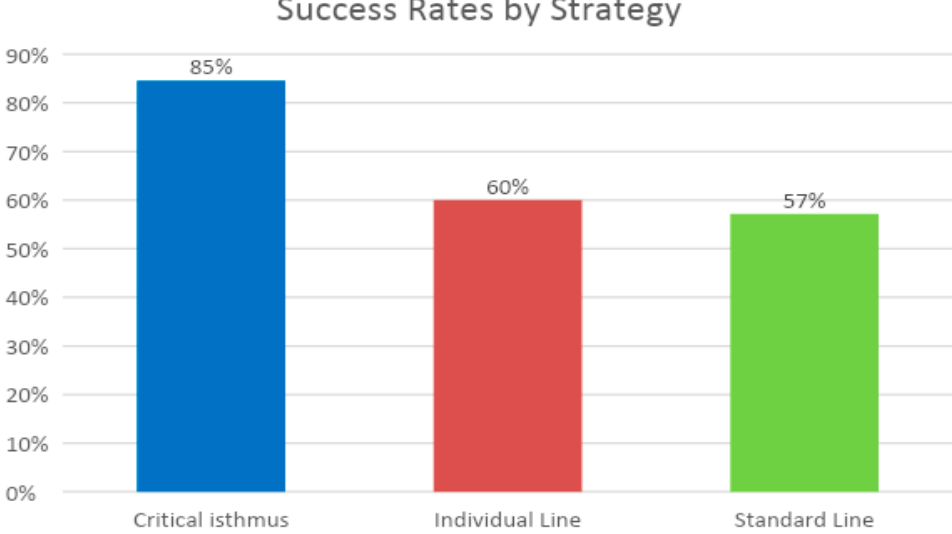
Figure 4. Clinical success dependent on the ablation strategy. Multi-procedure success after a mean follow-up time of 30 months. Differences were not significant. (Pearson Chi Square p = 0.28 and p = 0.12 when comparing critical isthmus vs. other lines).